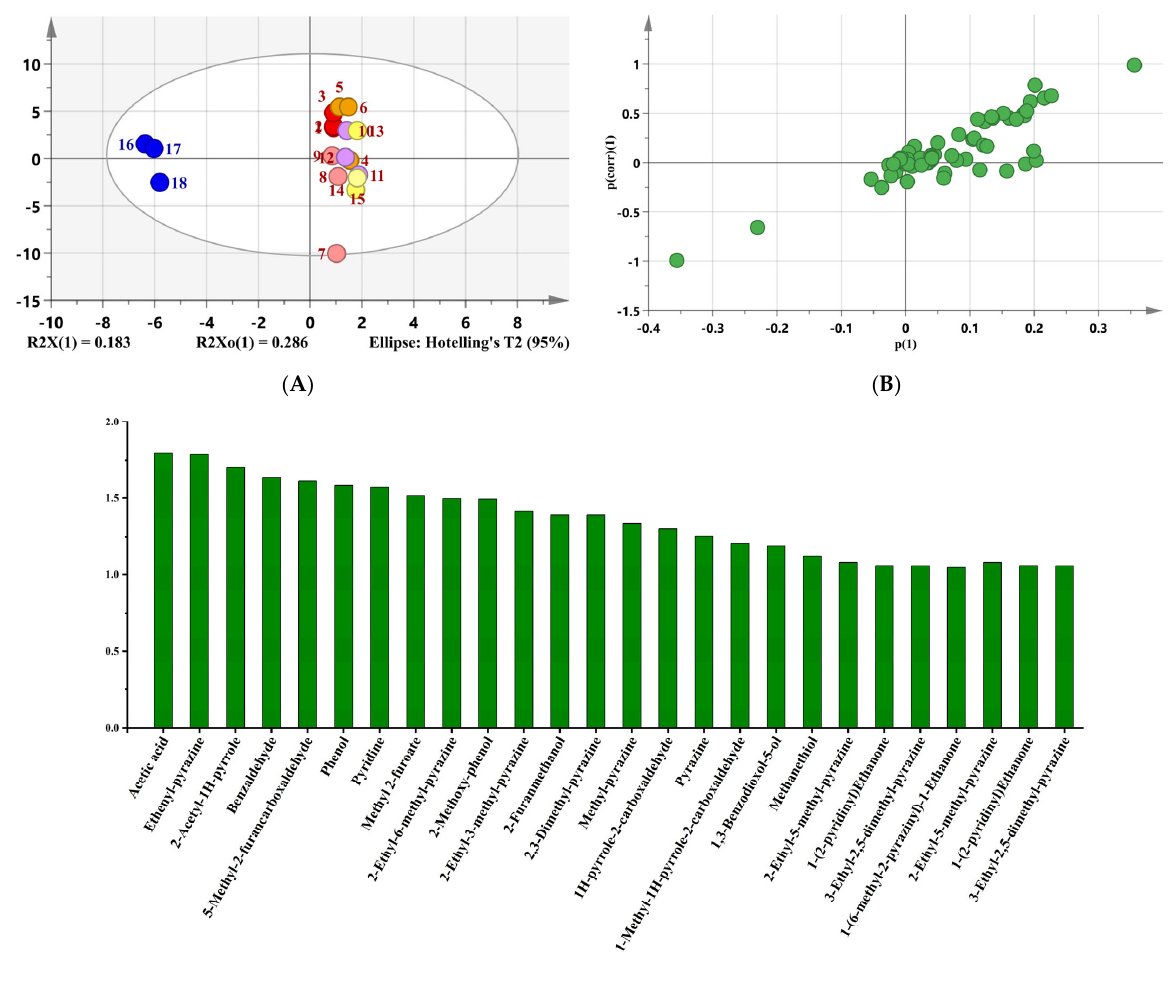
Figure 2. OPLS ‐ DA of XMXY and RSO samples: ( A ) the score plot, 1 − 3: Xiao Mo Xiang You 1; 4 − 6: Figure 2. OPLS-DA of XMXY and RSO samples: ( A ) the score plot, 1–3: Xiao Mo Xiang You 1; Xiao Mo Xiang You 2; 7 − 9: Xiao Mo Xiang You 3; 10 − 12: Xiao Mo Xiang You 4; 13 − 15: Xiao Mo Xiang 4–6: Xiao Mo Xiang You 2; 7–9: Xiao Mo Xiang You 3; 10–12: Xiao Mo Xiang You 4; 13–15: Xiao Mo You 5; 16 − 18: roasted sesame oil; ( B ) the loading S ‐ plot; ( C ) the VIP plot. Xiang You 5; 16–18: roasted sesame oil; ( B ) the loading S-plot; ( C ) the VIP